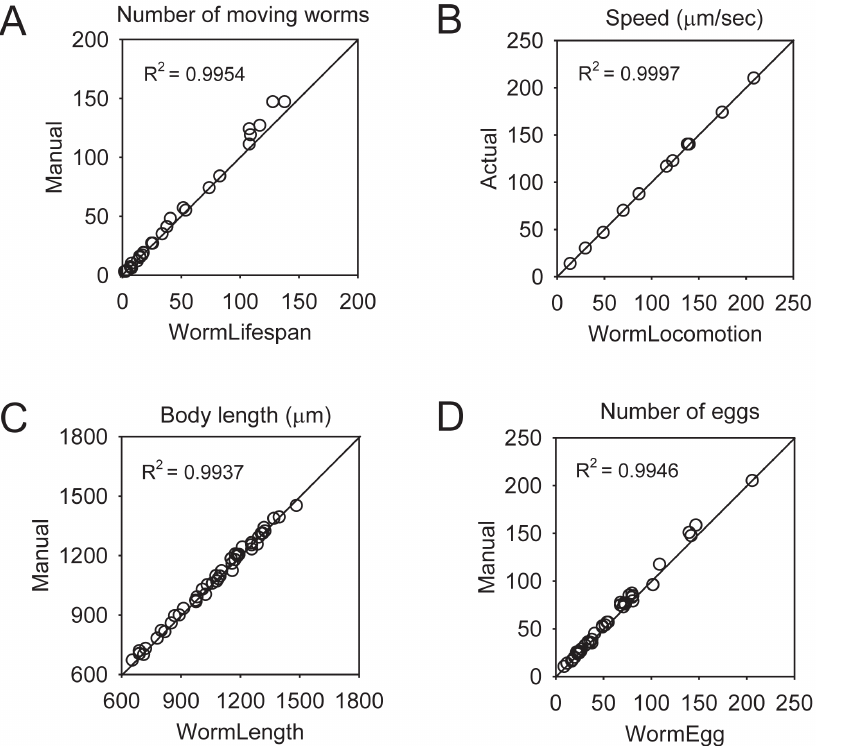
Figure 3. Performance of QuantWorm. (A) WormLifespan. Moving worms were manually counted by aspirating individual worms from a well under a basic light microscope after images were captured ( n =26 wells). (B) WormLocomotion. Worm simulation videos were created and then analyzed by the WormLocomotion software ( n =11 videos). (C) WormLength. In the manual method, worm length was manually measured from images using an Adobe Photoshop length measurement tool ( n =46 worms). (D) WormEgg. In the manual method, eggs were manually counted by aspirating eggs from a well after images were taken ( n =42 wells). The diagonal line represents the ideal case where the computer measurements equal the manual